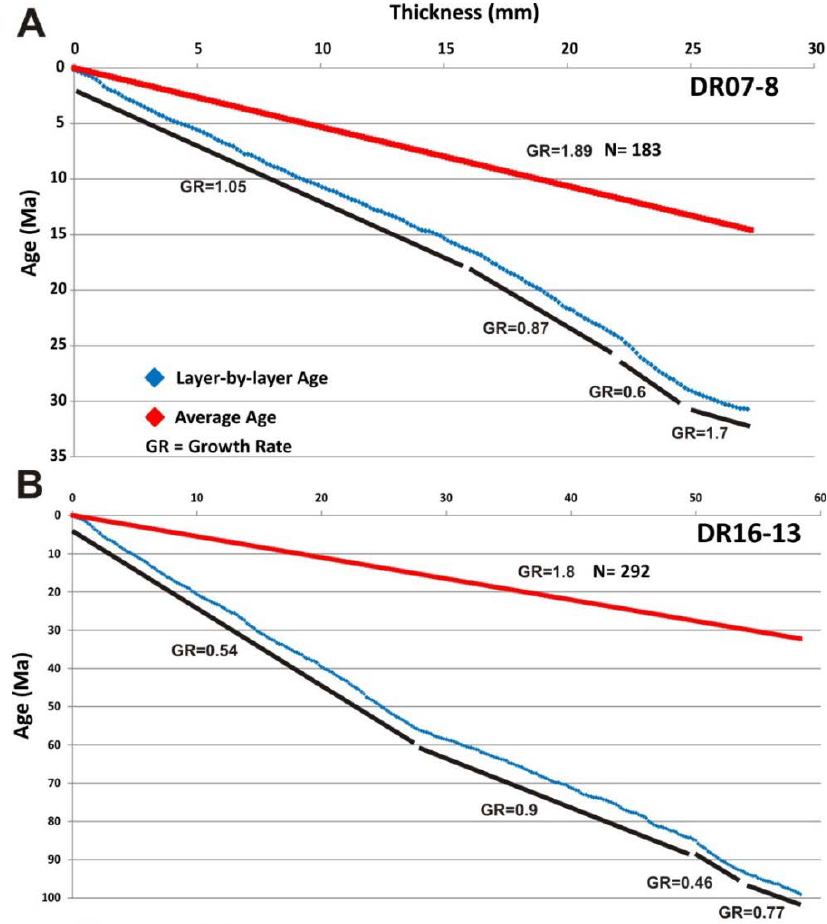
Figure 11. Layer-by-layer growth rate and age compared with bulk average growth rate and age of ( A ) crust DR07-8 and ( B ) crust DR16-13. Both crusts show several sections with different mean growth rates identified by black continuous lines.